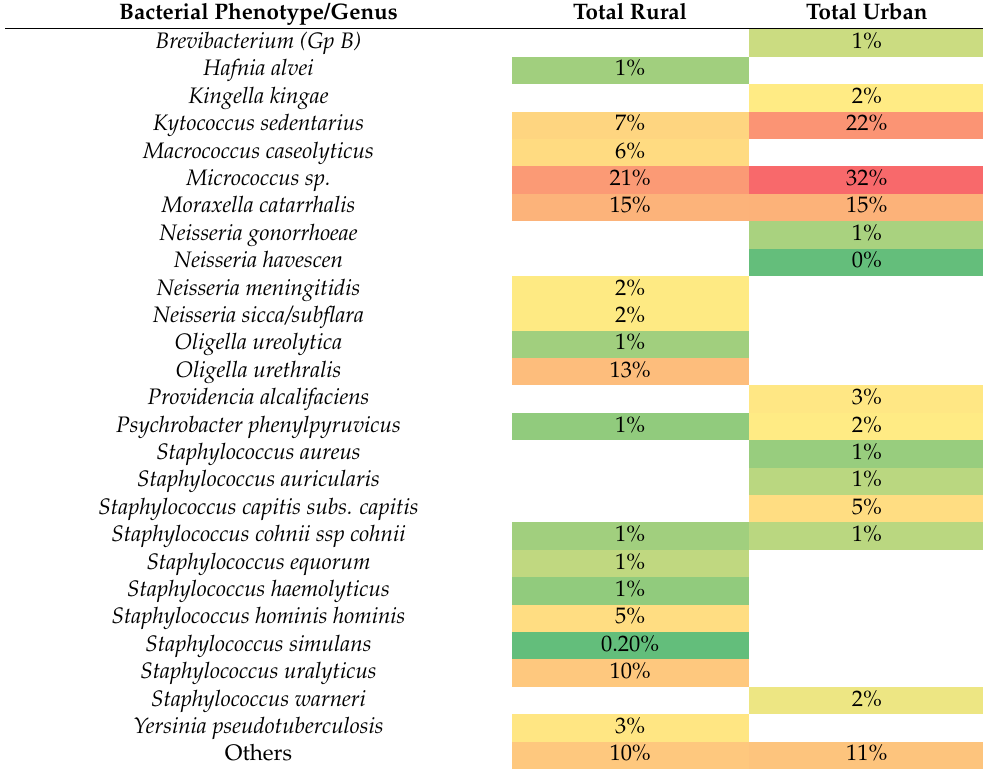
Table 3. Heat Map for frequency of airborne bacteria (%) in rural and urban PHCCs. Bacterial Phenotype/Genus Total Rural Total Urban Brevibacterium (Gp B)